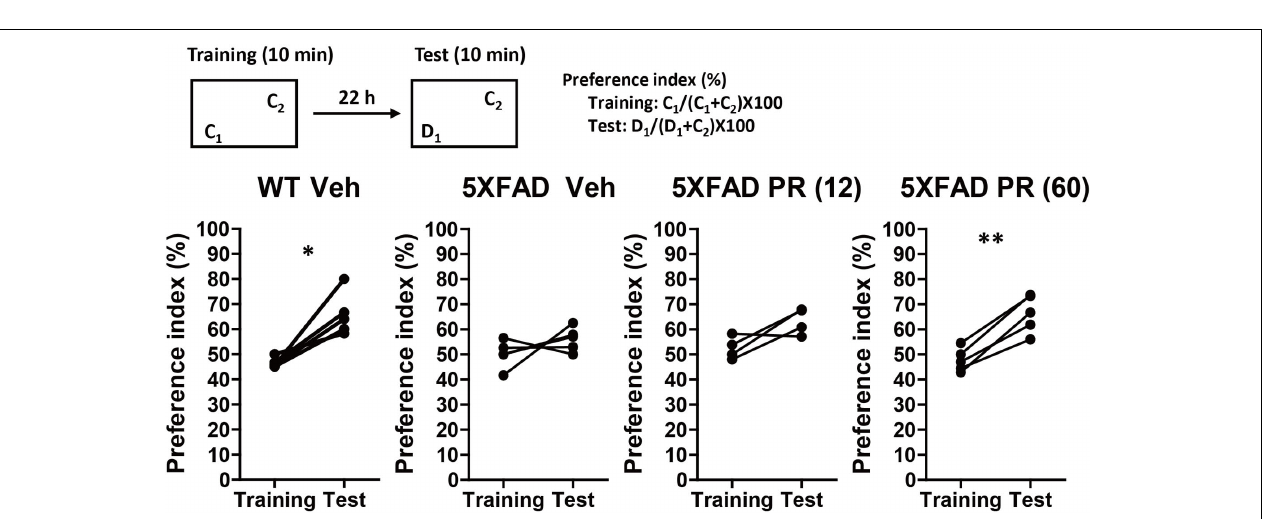
FIGURE 1 | Memory function in 5XFAD mice before the administration of Polygalae Radix (PR) extract. Novel object recognition tests were performed using 4-month-old wild-type (WT) and 5XFAD mice. Preference indices of objects A 2 (training session) and B 2 (test session) were quantified. The values of preference indices of each mouse are shown. ∗∗ P < 0.01, ∗∗∗ P < 0.001, paired t -test, n = 5–14 mice.